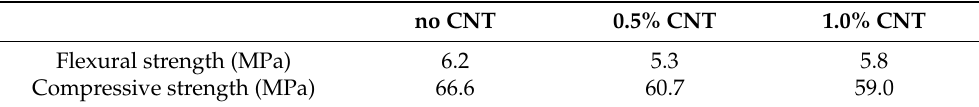
Table 3. Compressive and flexural strength of geopolymer.